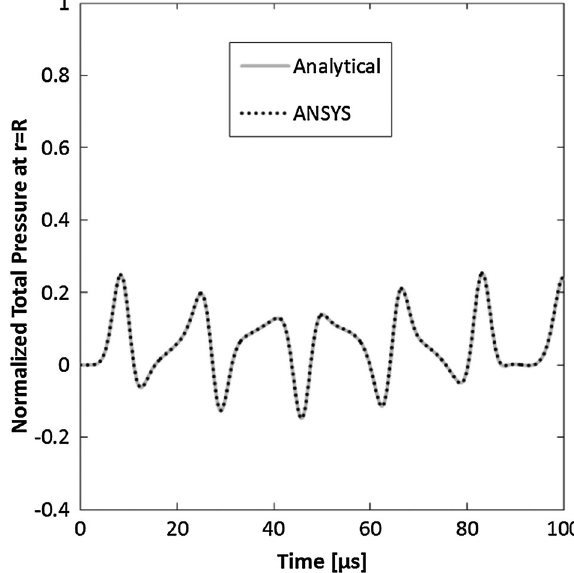
FIG. 4. Normalized total pressure at r ¼ 0 for the test case assuming plane stress.